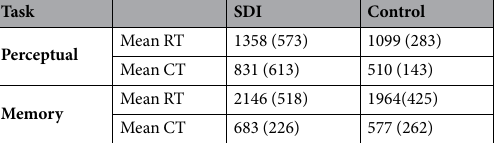
Table 2. Mean Response Time (RT) and mean Confidence Time (CT) for SDI and Control